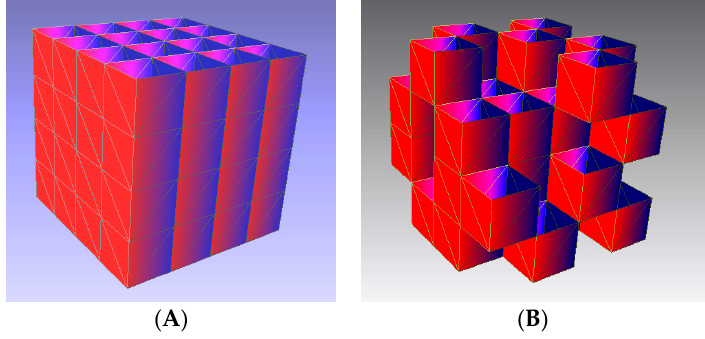
Figure 10. Demo of volume calculation. ( A ) Bounding box was divided into voxels; ( B ) Voxels left after removing unused voxels.